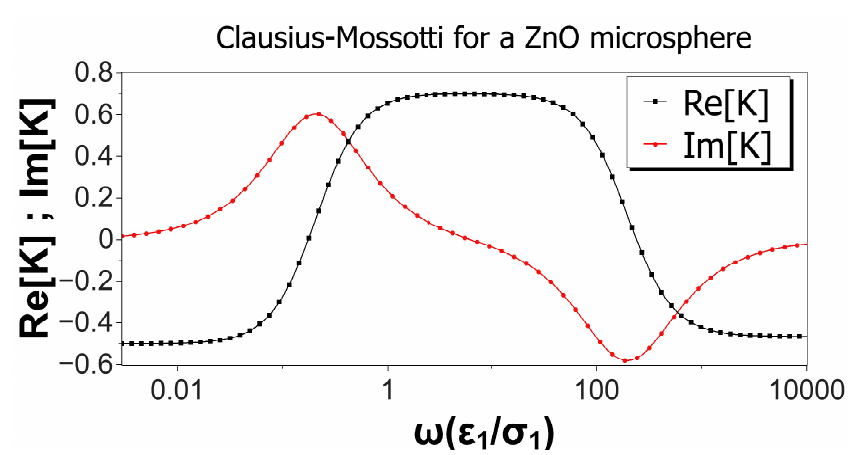
Figure 2. Real and imaginary parts of the Clausius–Mossotti factor versus nondimensional frequency for a ZnO microsphere immersed in a KCl solution. Values of the material properties are taken from Table 1. The microsphere is 10 microns in diameter, and the nondimensional Debye length is